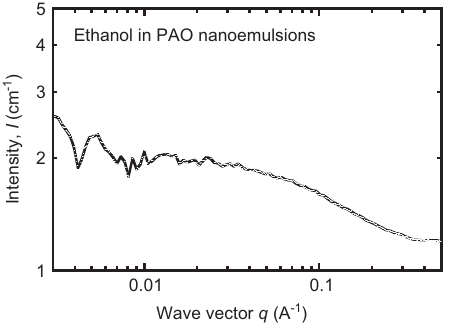
Figure 3 The intensity I vs. the wave vector q measured in the ethanol-in-PAO nanoemulsion fluids.